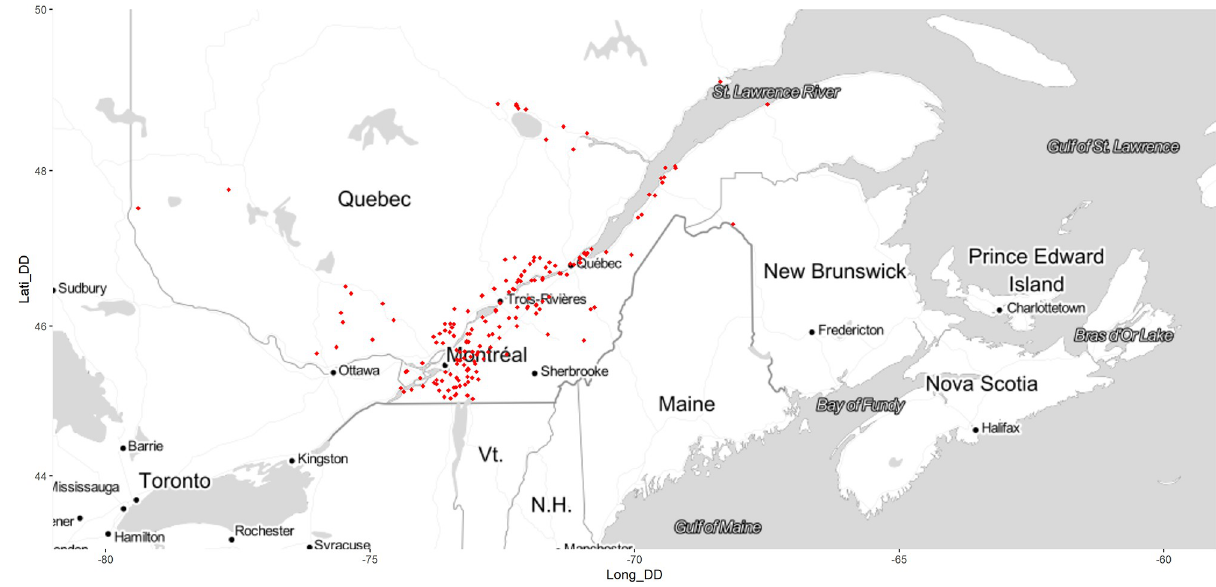
Fig 1. Repartition of soil sampling areas on eastern provinces in Canada. Map tiles by Stamen Design, under CC BY 3.0. Data by OpenStreetMap, under ODbL. Contains information from OpenStreetMap and OpenStreetMap Foundation, which is made available under the Open Database License. http://maps.stamen.com/#toner/12/37.7706/-122.3782.